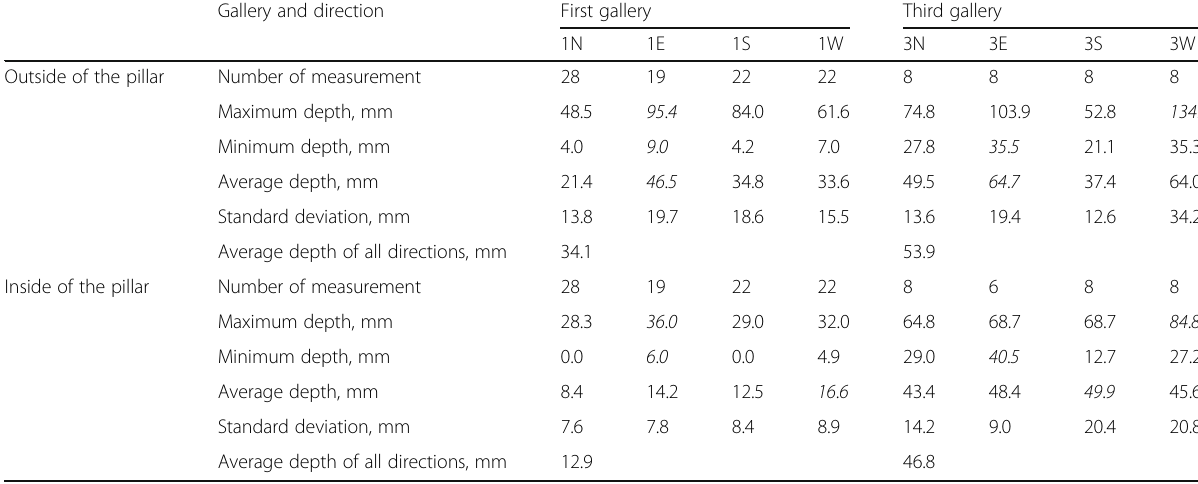
Table 1 Hollow depths of the inner pillars of the first and third galleries. Italics mean maximum values of the hollow depths Gallery and direction First gallery Outside of the pillar